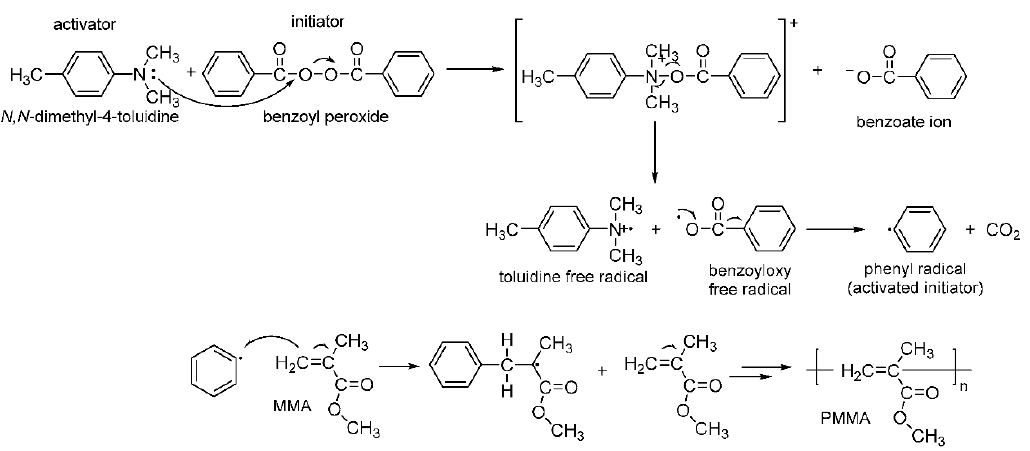
Figure 2. Schematic diagram showing methyl methacrylate (MMA) polymerization. Reproduced with permission from [34].